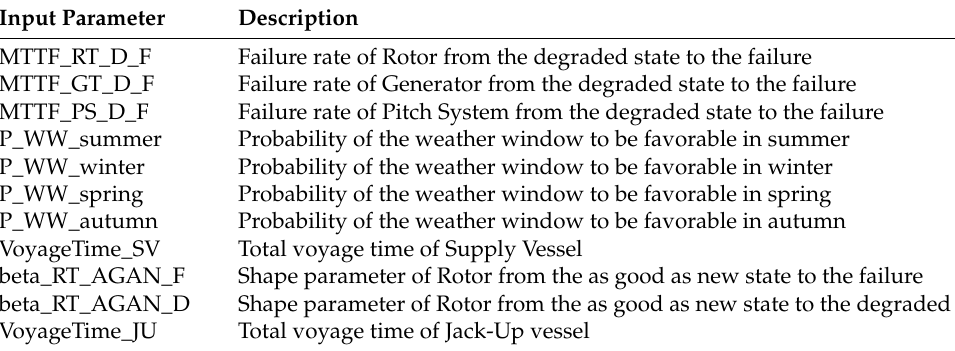
Figure 11. Elasticity factors of input parameters in terms of availability. Table 16. Description of the input